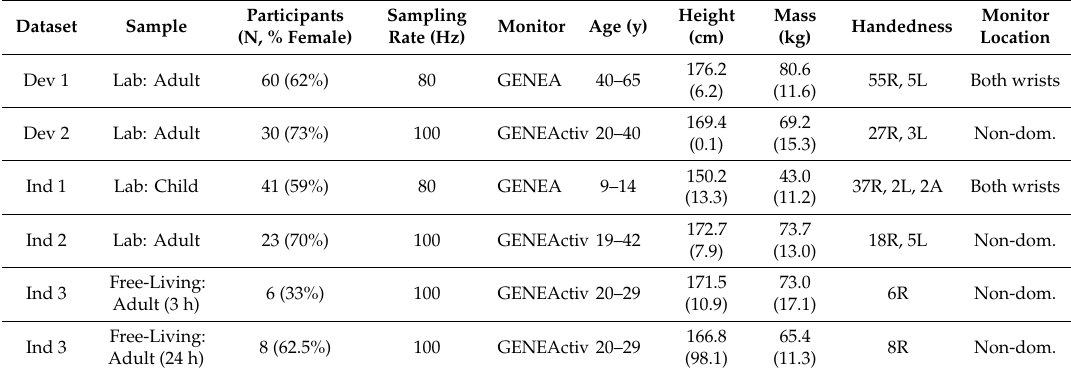
Table 1. Characteristics of development and independent datasets.